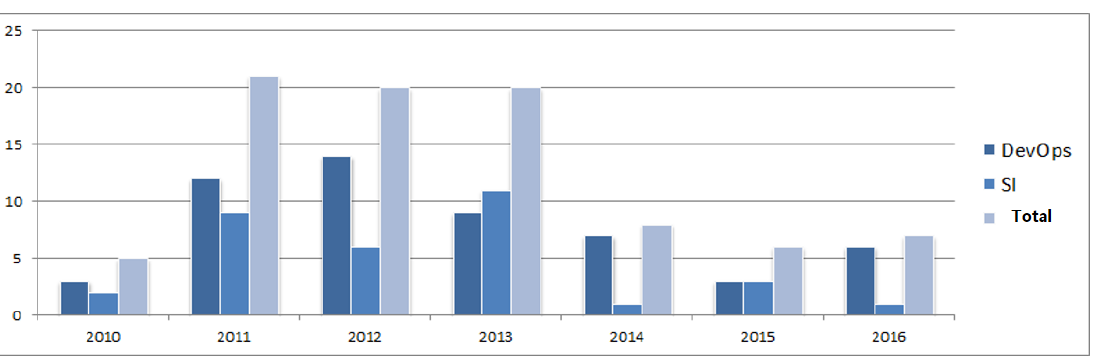
Figure 11. Sample data distribution status by year.